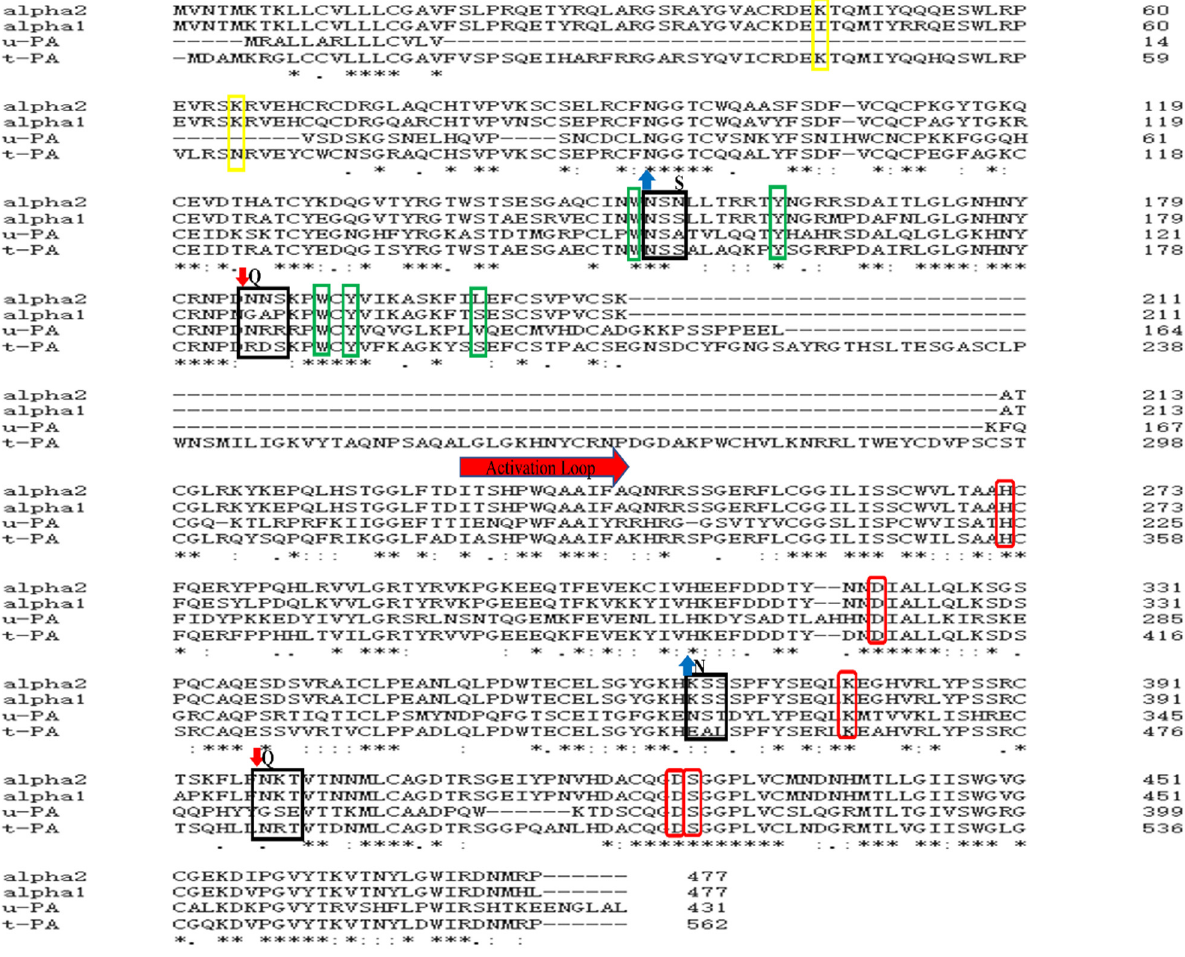
Figure 1. The Alignment of Animo acid sequence for DSPA α 2, DSPA α 1, t-PA and u-PA. Sequence alignment of DSPA α 2 with DSPA α 1, t-PA, and u-PA using the ClustalX program. The yellow rectangular boxes represent the sites (K46 and K65) associated with the fibrin-sensitive-related function in the F region. The green rectangular boxes represent the ligand-binding sites (W152, Y162, W190, Y192, and L201) in the EGF region. The red rectangular boxes represent the active pocket-associated sites (H272-D321-S428 and K379-D427) and the thick red arrow represents the activation loop. The black rectangular boxes indicate the glycosylation-related sites. The red arrows pointing down represent the deglycosylation-related mutation sites in DSPA α 2, and the blue arrows pointing up represent the glycosylation-related mutation sites. The bold letters represent the mutated positions and the mutated amino acid residues.